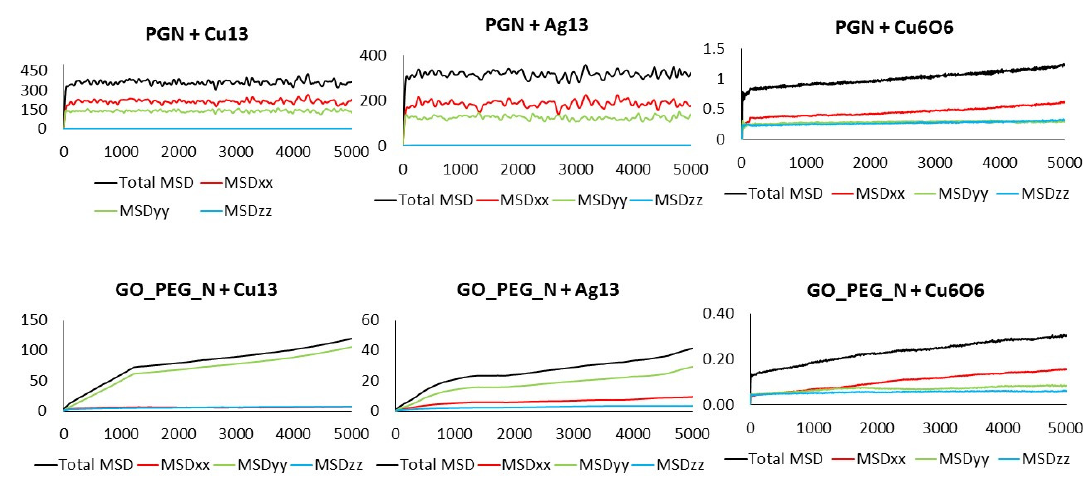
Figure 10. Total MSD (black) and MSD in x, y, and z directions of the clusters interacting with pristine and functionalized graphene monolayers. Axis units: time in ps (x), MSD in Å 2 (y).